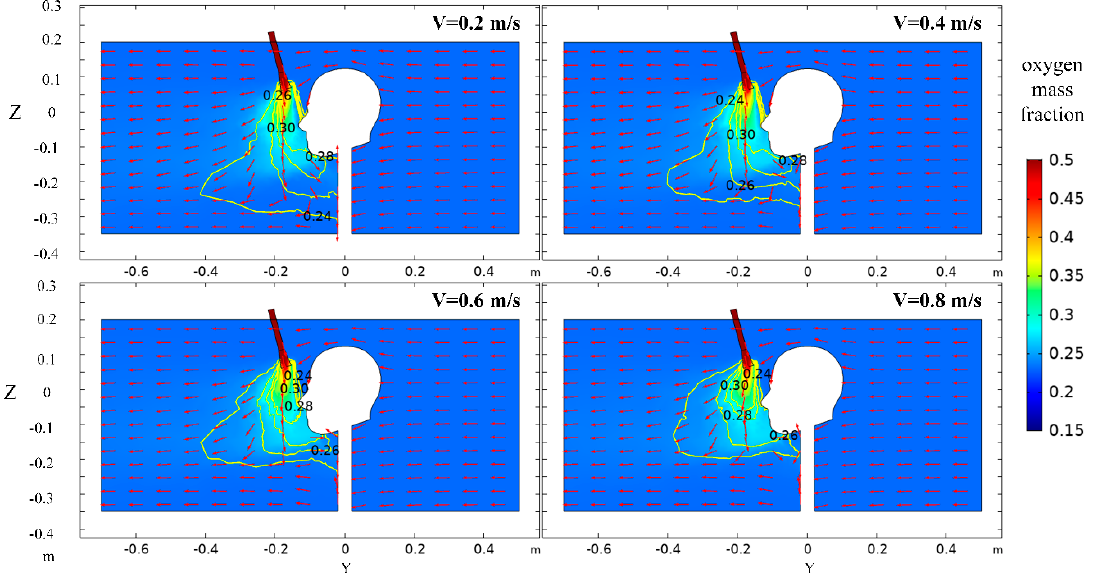
Figure 12. Distribution of oxygen mass fraction in X = 0 m section at different tunnel airflow velocities.